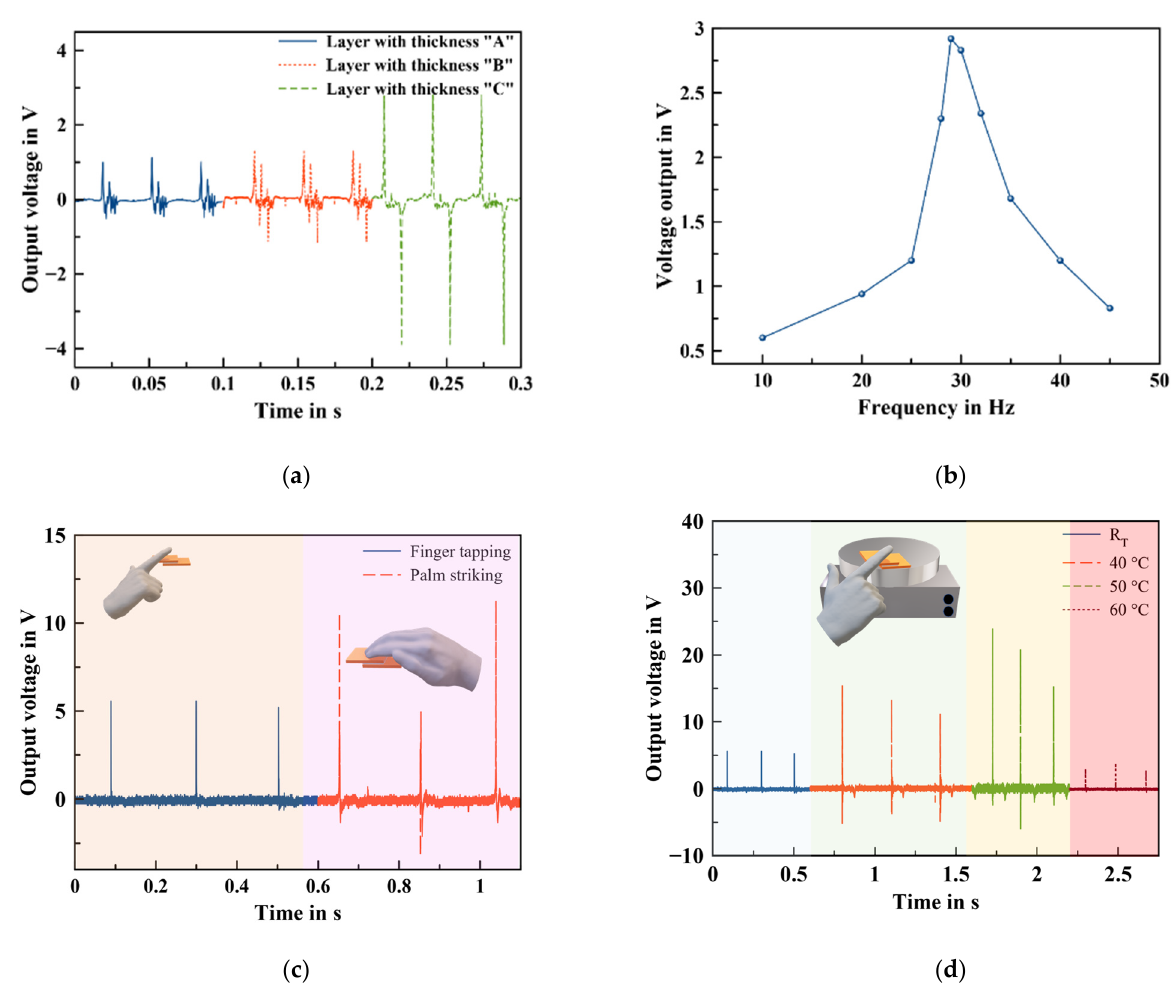
Figure 6. Nanogenerators performances under different conditions: ( a ) output voltage depending on the thickness, ( b ) test under different frequencies from 10 Hz to 45 Hz, ( c ) tapping and striking tests, and ( d ) test under finger tapping and different temperatures.